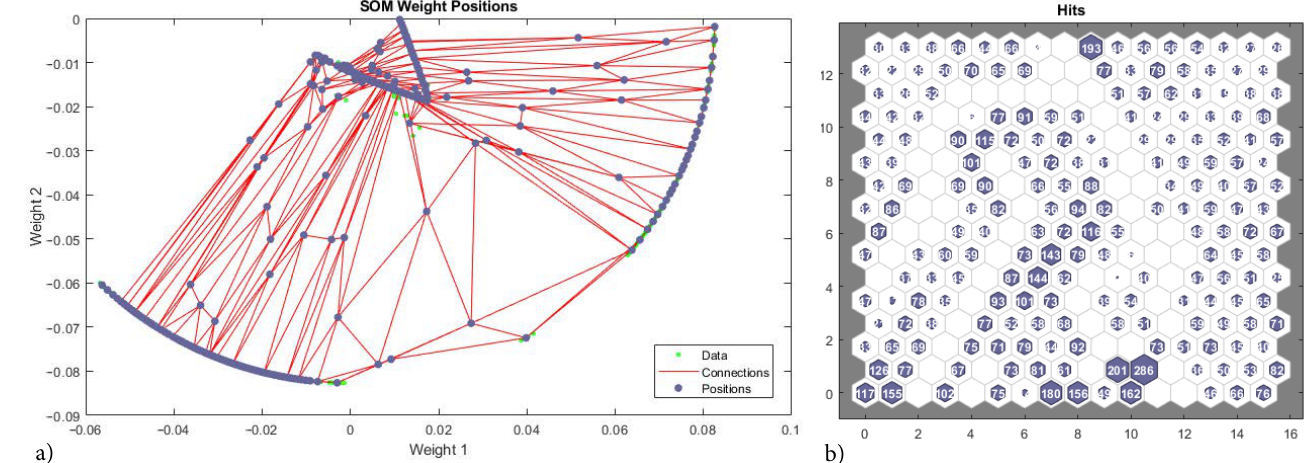
Figure 13. Neural net clustering 12,000 samples, 2D strain (cid:101) xx – (cid:101) yy . 16 and hits. ( a ) SOM weight positions. ( b ) Hits count